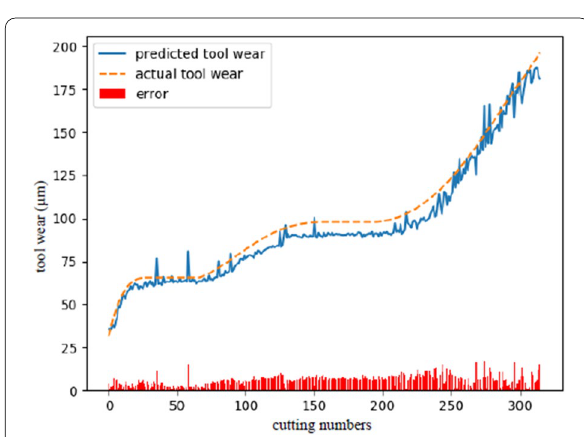
Figure 14 Results of the second experimental case: the predicted tool wear, the actual tool wear and the